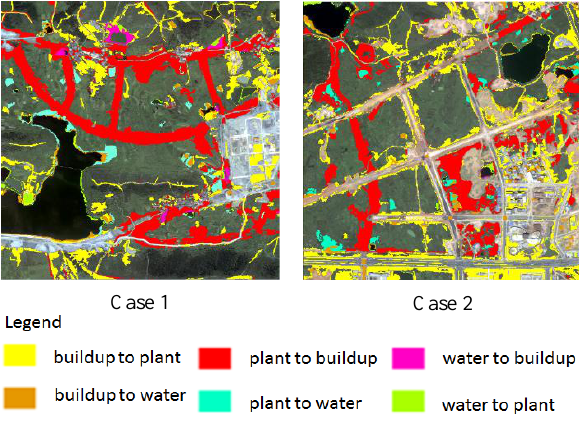
Figure 7 Change Detection Results